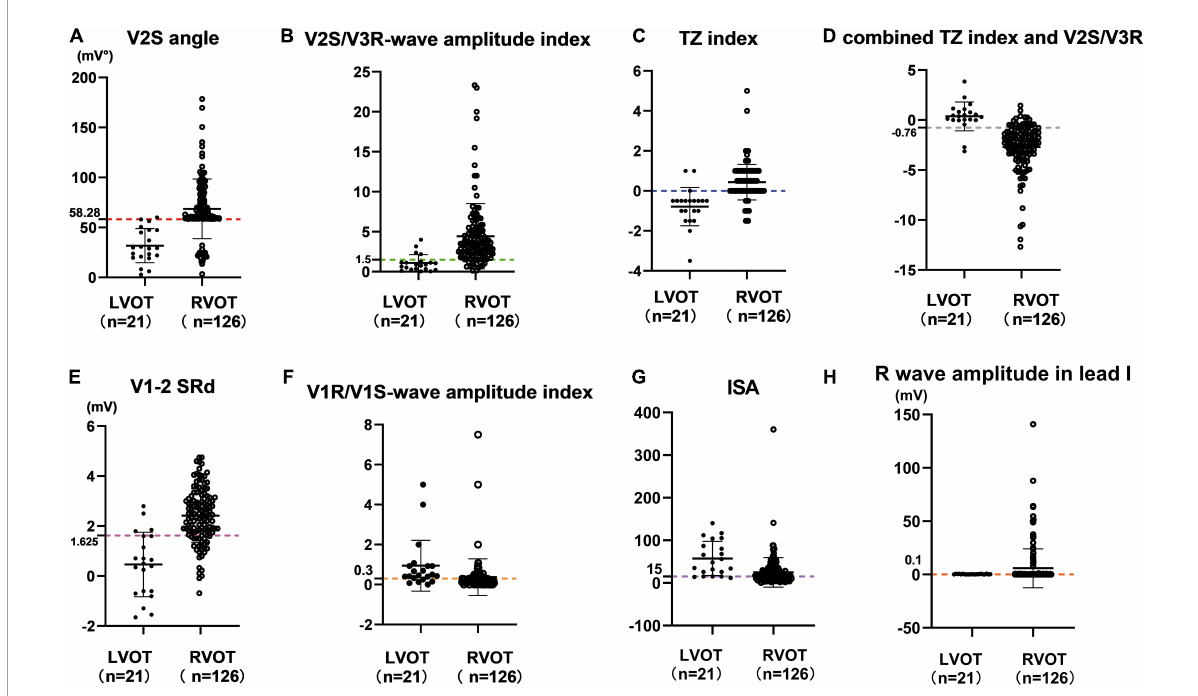
FIGURE4 Scatterplot diagram of the V2S angle (A) and several ECG algorithms (B–H) between ventricular arrhythmias from RVOT and LVOT. The red dotted line indicates the optimal cut-off value of the V2S angle. The V2S angle of 58.28 mV ◦ predicted the RVOT origin with 85.7% sensitivity and 95.2% specificity (PPV: 99.1%; NPV: 52.6%). Other diagnostic indexes for predicting RVOT origin (sensitivity, specificity, PPV, NPV) are shown in Table 3 .